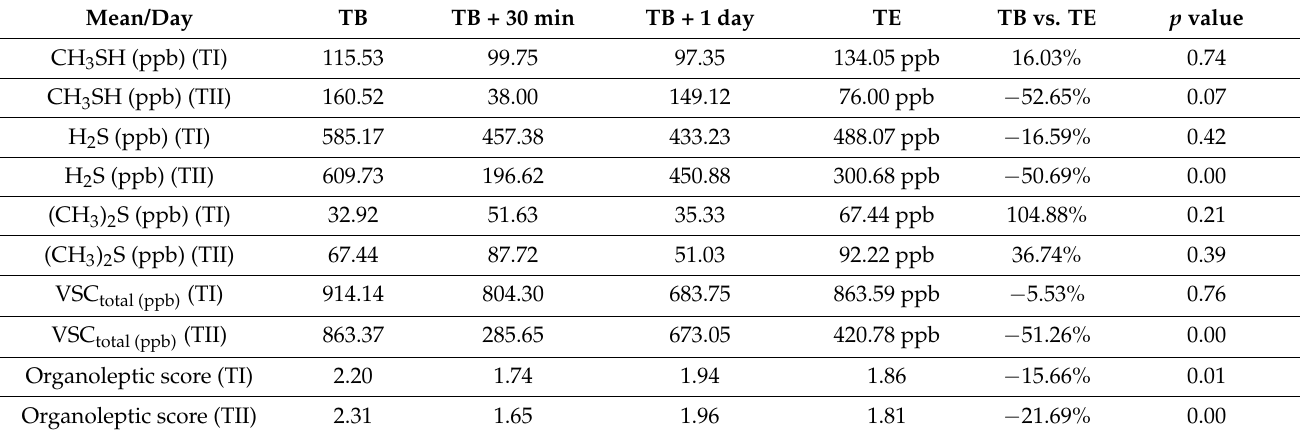
Table 2. Comparison of intra-oral halitosis parameters between Therapies I and II.